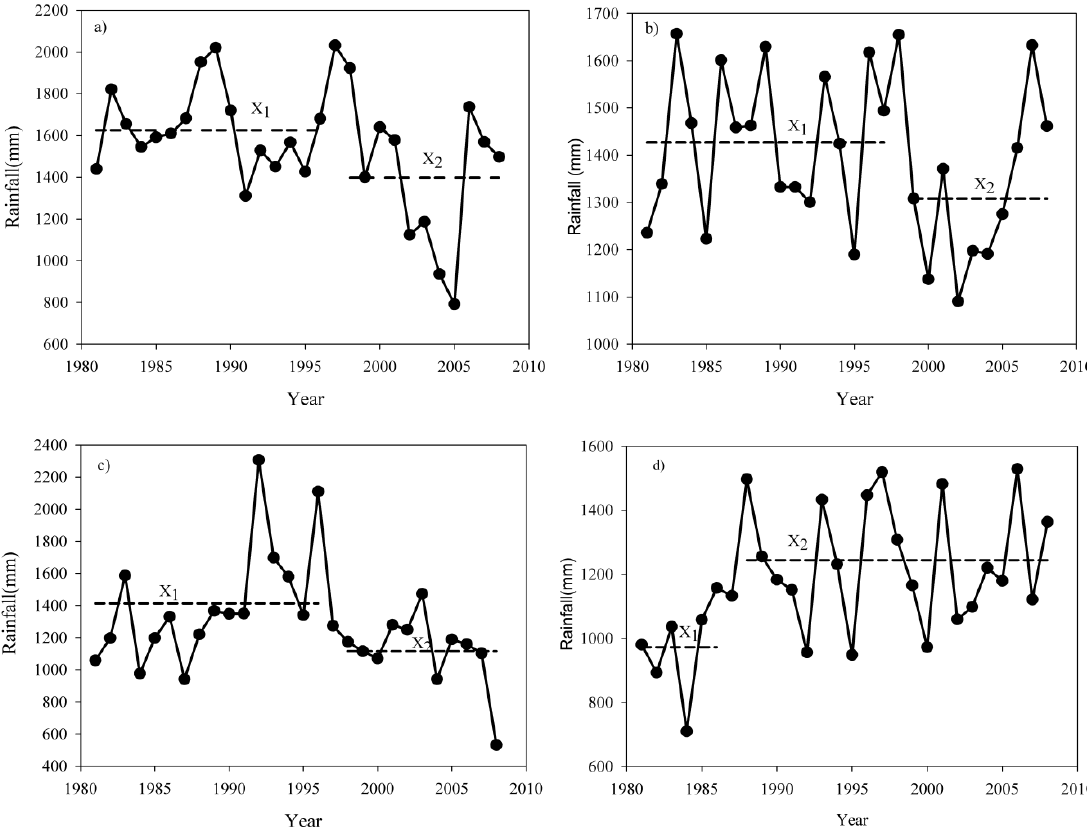
Figure 6. Annual rainfall time series plots for the change of time detection at ( a ) Shebe station, ( b ) Sekoru station, ( c ) Wolkite station, and ( d ) Assendabo station. The dashed lines represented by X 1 and X 2 are the mean of the time series before and after the change point respectively.